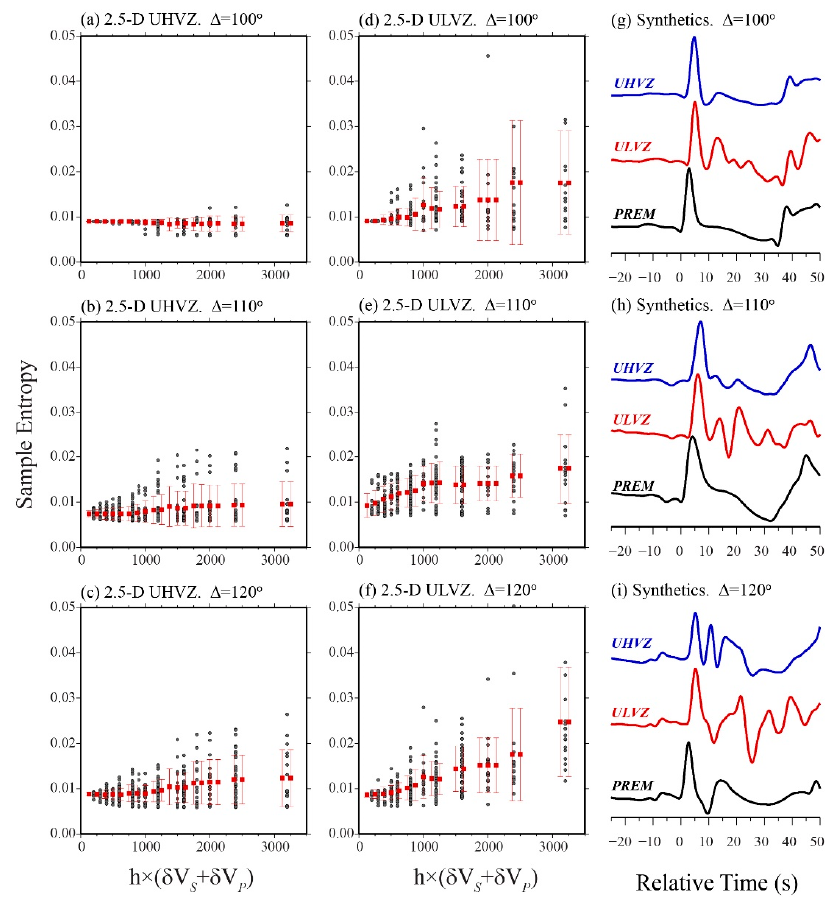
Figure 9. Sample entropy for a coarsely sampled UHVZ and ULVZ model space of 430 models. ( a – c ) Sample entropy is shown for UHVZs as a function of UHVZ strength. Individual measurements are shown with gray circles and averages in 125 km% increments are shown with red boxes and 1- σ standard deviation error bars are drawn. ( d – f ) show the same except for ULVZ models. Sample entropy is shown for synthetic seismograms at a single epicentral distance of ( a , d ) ∆ = 100 ◦ , ( b , e ) ∆ = 110 ◦ , and ( c , f ) ∆ = 120 ◦ . Example radial component displacement synthetic seismograms are shown in panels ( g – i ) for the PREM model (black), a ULVZ model with δ V S = − 40%, δ V P = − 40%, h = 40 km, l = 6 ◦ , and ∆ edge = 17 ◦ (red), and a UHVZ model with δ V S = +40%, δ V P = +40%, h = 40 km, l = 6 ◦ , and ∆ edge = 17 ◦